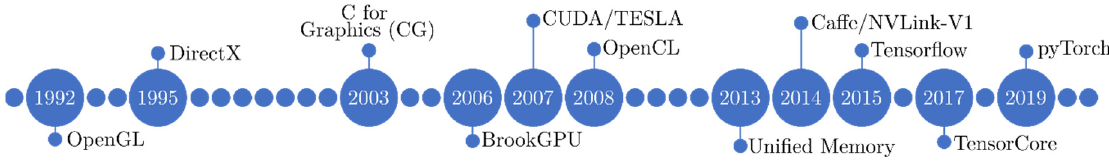
Figure 2. Most significant milestones over time on GPU-based hardware acceleration for image processing.